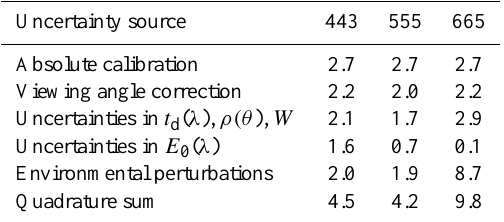
Table 6. Uncertainty budget (in percent) for R rs determined from SeaPRISM